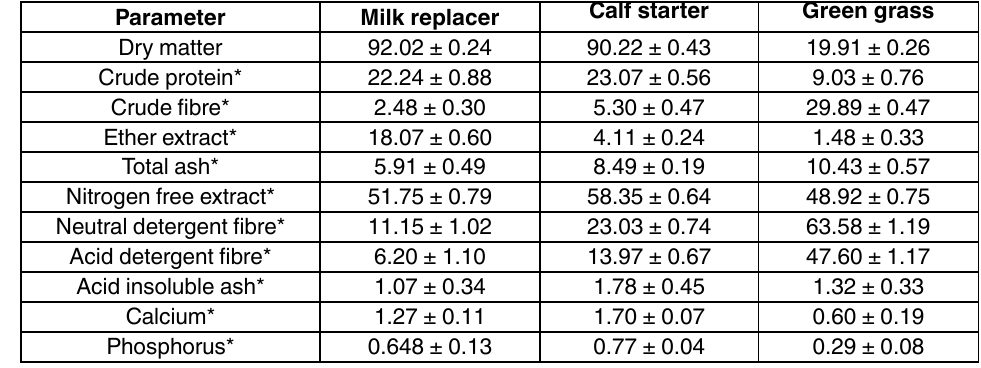
table 2. Chemical composition 1 of milk replacer, calf starter and green grass fed to the experimental calves,